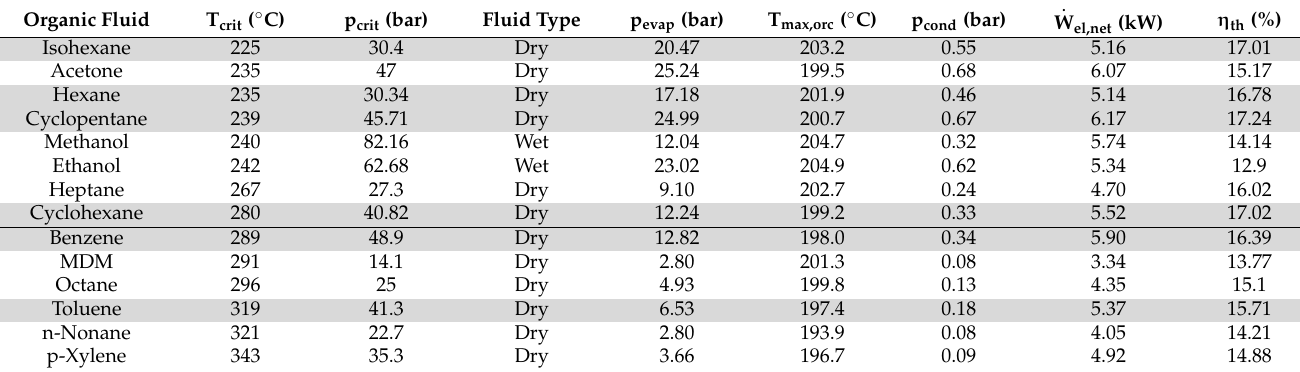
Table 5. Properties and calculated design thermal efficiency of the examined organic fluids [65,66]. Organic Fluid